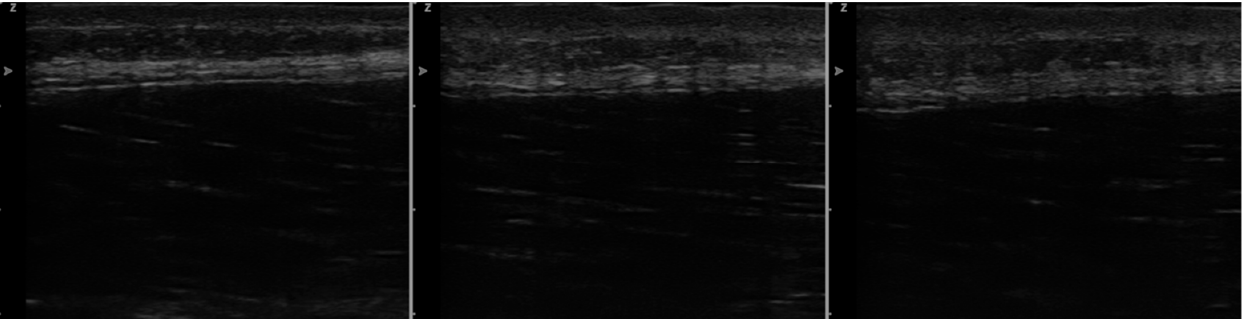
Figure 6. Observed changes in the area of the superficial fascia before instrument-assisted manual therapy (IAMT) intervention ( left ), immediately after IAMT intervention ( middle ), and 45 min after IAMT intervention ( right ) on the ultrasound images.